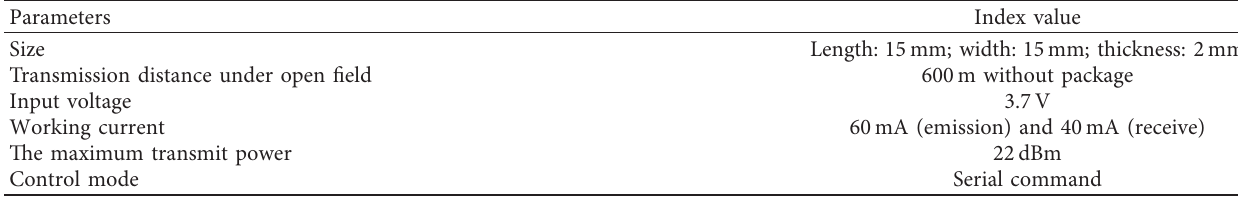
Table 2: Technical parameters of wireless transmission module.